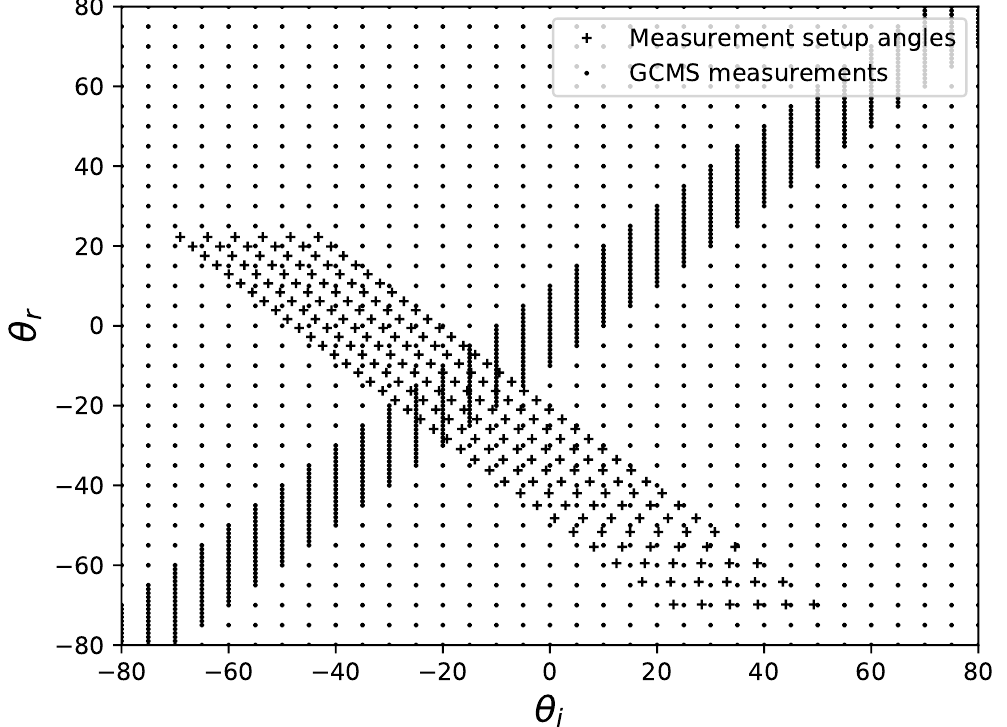
Figure 5. θ i and θ r angles at which measurements are performed using our measurement setup and GCMS. Measurements made using GCMS and our measurement setup had different dimensions. GCMS measurement dimensions were n × m × 35, where n and m are the incident ( θ i ) and reflection ( θ r ) angles at the sample surface. The measurement unit was a spectral radiance factor in the range of 390 nm–730 nm at 10-nm intervals; whereas, measurements performed using our measurement setup were per pixel, where each pixel corresponds to the curved sample surface point ( P ), thus making a unique incident and reflection angle relative to the surface normal. The measurement data obtained consisted of 3 channels (R, G, and B). As we used a high resolution camera, the measurement points ( P ) (or the θ i and θ r angle combinations) were many (approximately 1000 pixels horizontally) and different compared to the GCMS measurements. Please note that the measurement setup measurements are sampled at every 20 pixels for visual representation in Figure